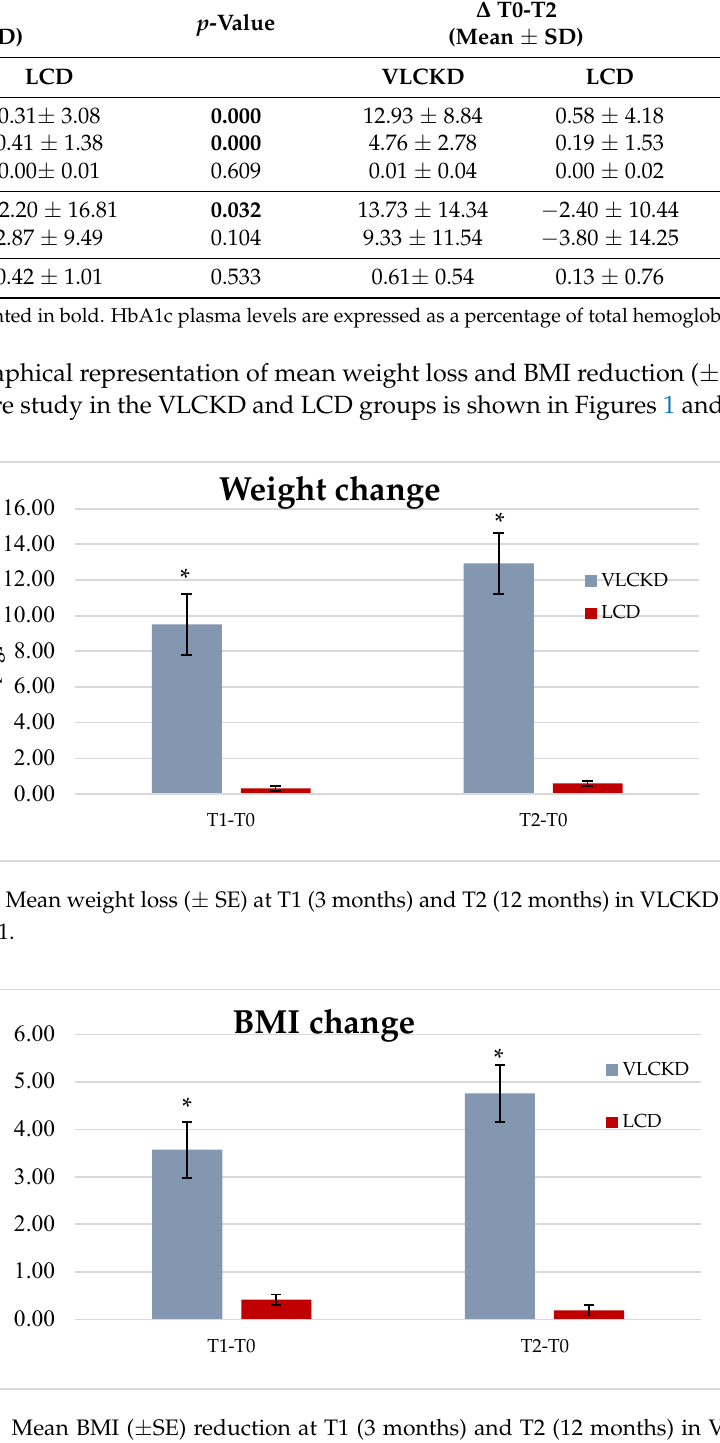
Figure 3. Kinetics of HbA1c values throughout the study (T0, T1 and T2). * p < 0.005.